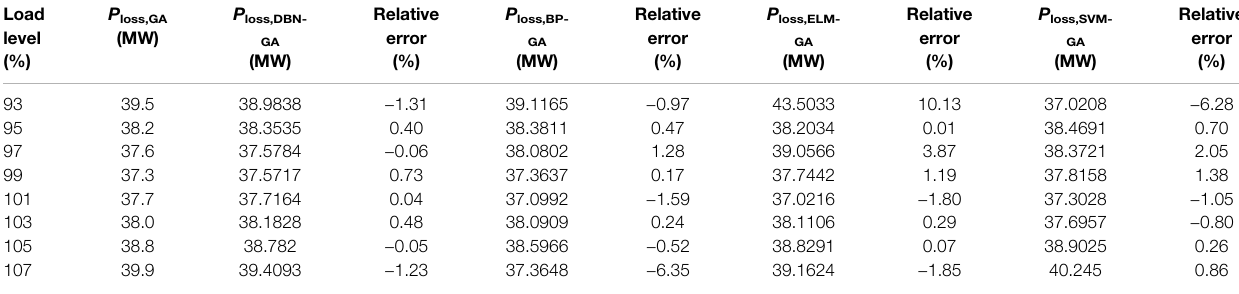
TABLE 5 | Errors of the data-driven genetic algorithm (GA) and model-driven GA. Load level